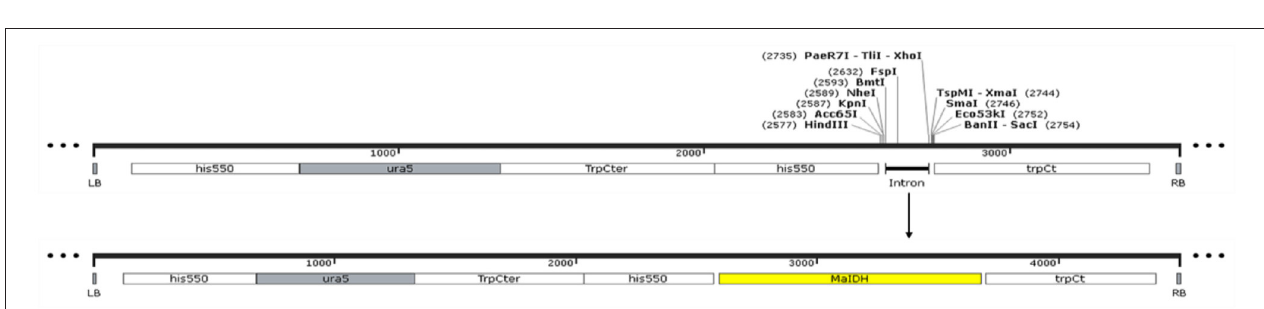
downregulated 3.5-fold, and MaIDH4 was the only MaIDH